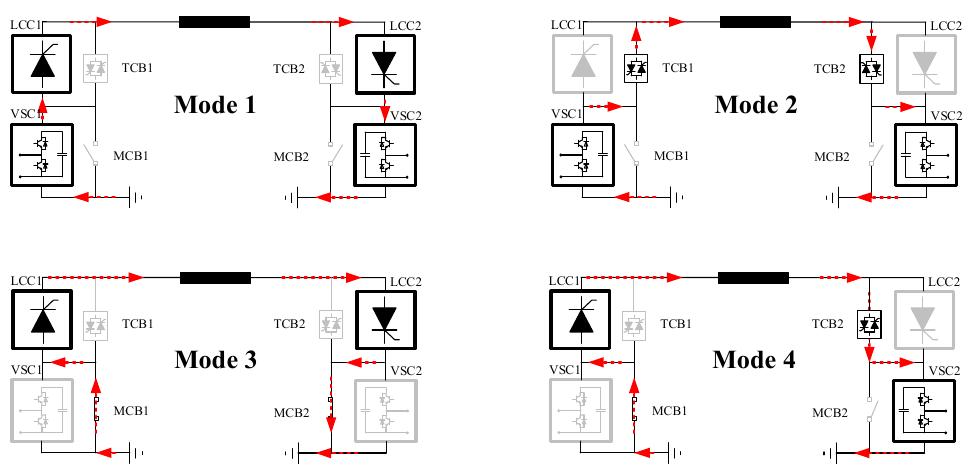
Figure 1. LCC-VSC serial hybrid HVdc structure.